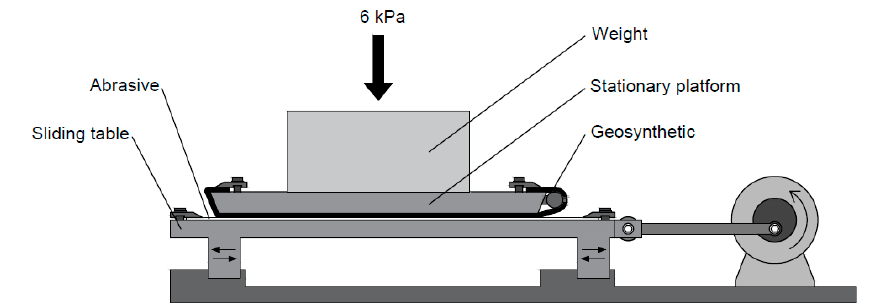
Figure 2. Schematic representation of the equipment for abrasion tests.